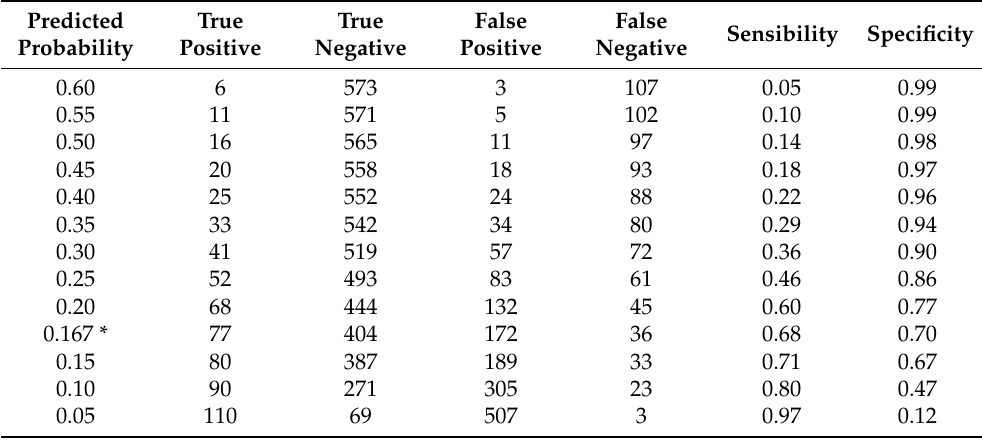
Table A2. Sensibility and specificity of the prediction model for different predicted probability